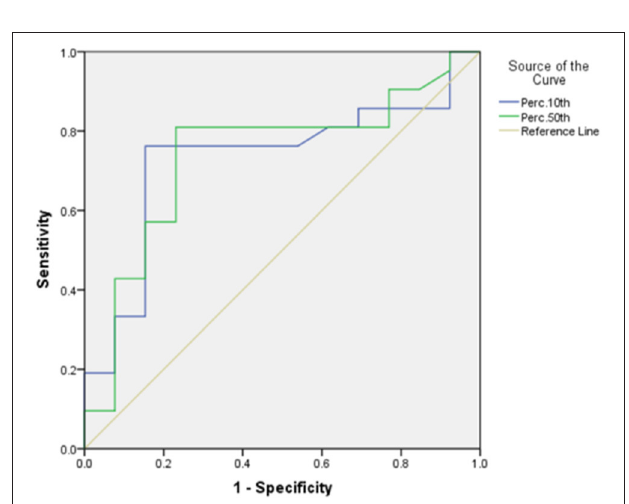
FIGURE 7 | The ROC curves of the 10th percentile, 50th percentile in the ADC histogram between the endometrial mesenchymal sarcoma group and degenerative hysteromyoma